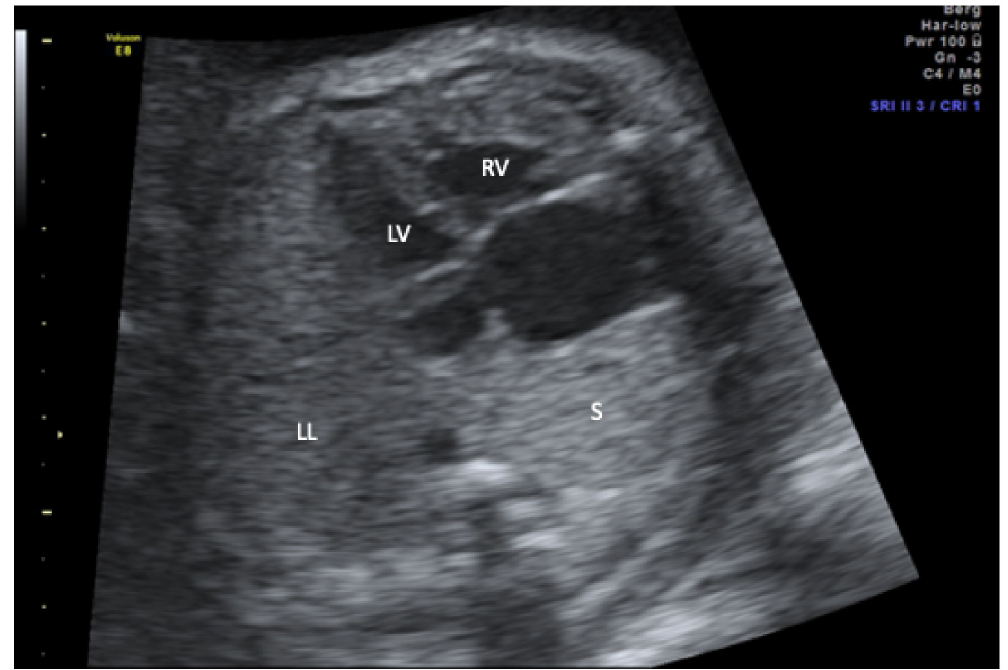
Figure 1. Transverse thoracic view in b-mode demonstrating dextroposition of the heart and a small echogenic mass that represents the sequestration (S) behind the heart on the right side. LL, left lung; LV, left ventricle; RV, right ventricle.